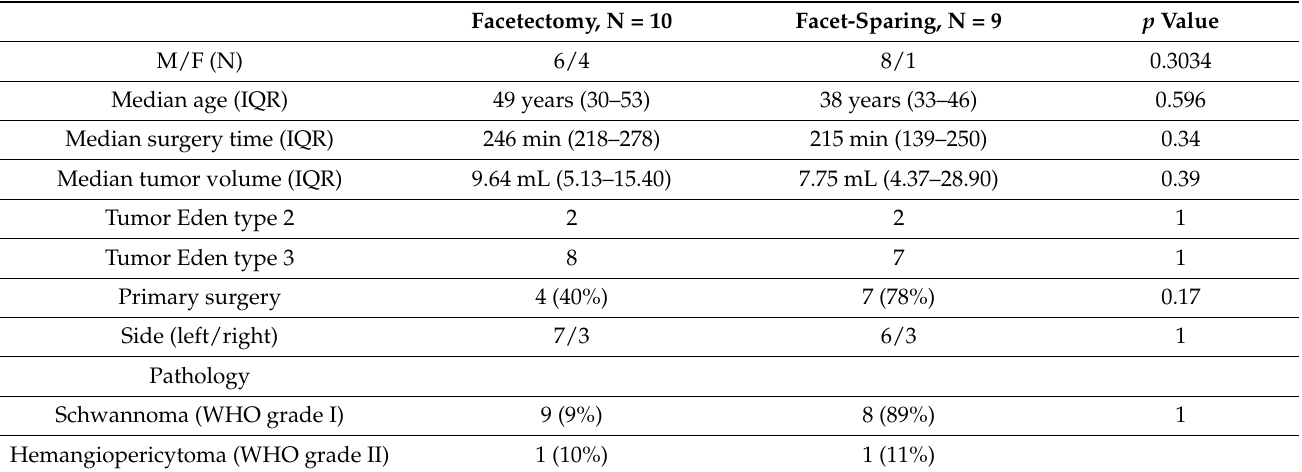
Table 1. Baseline patient